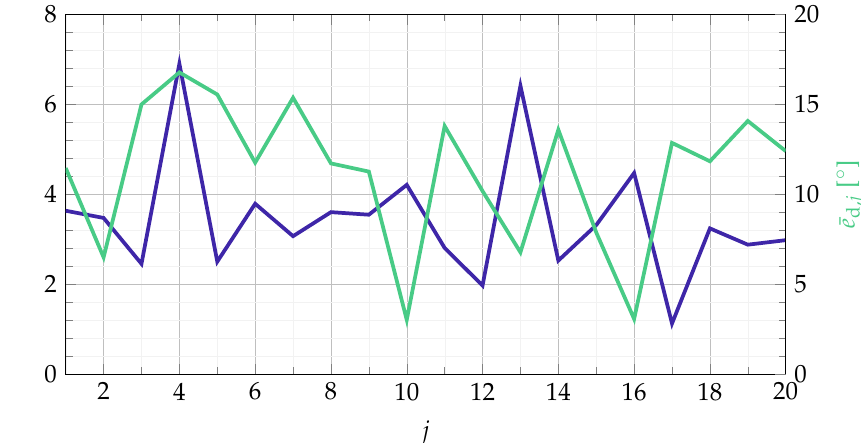
Figure 11. Mean localization errors for all tested position-orientation pairs. The index j depicts the respective position-orientation pair p of the sensor as defined in Figure s, j